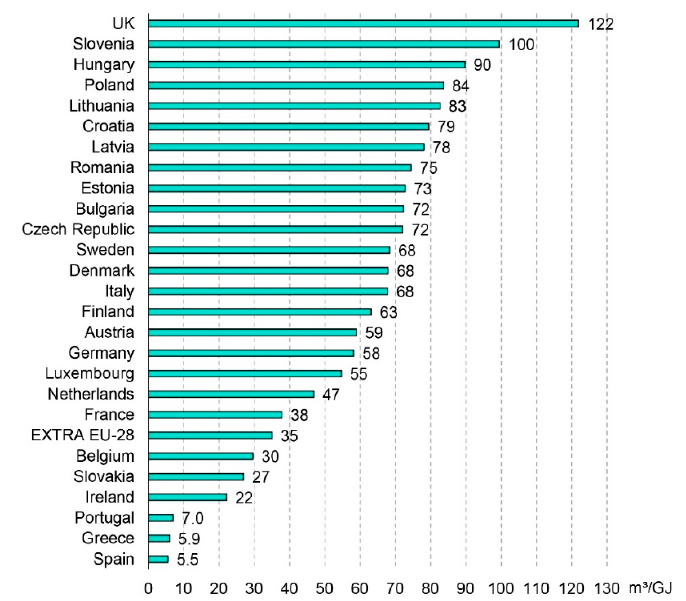
Figure 1. Water footprint of wood per unit of energy produced (m 3 /GJ).